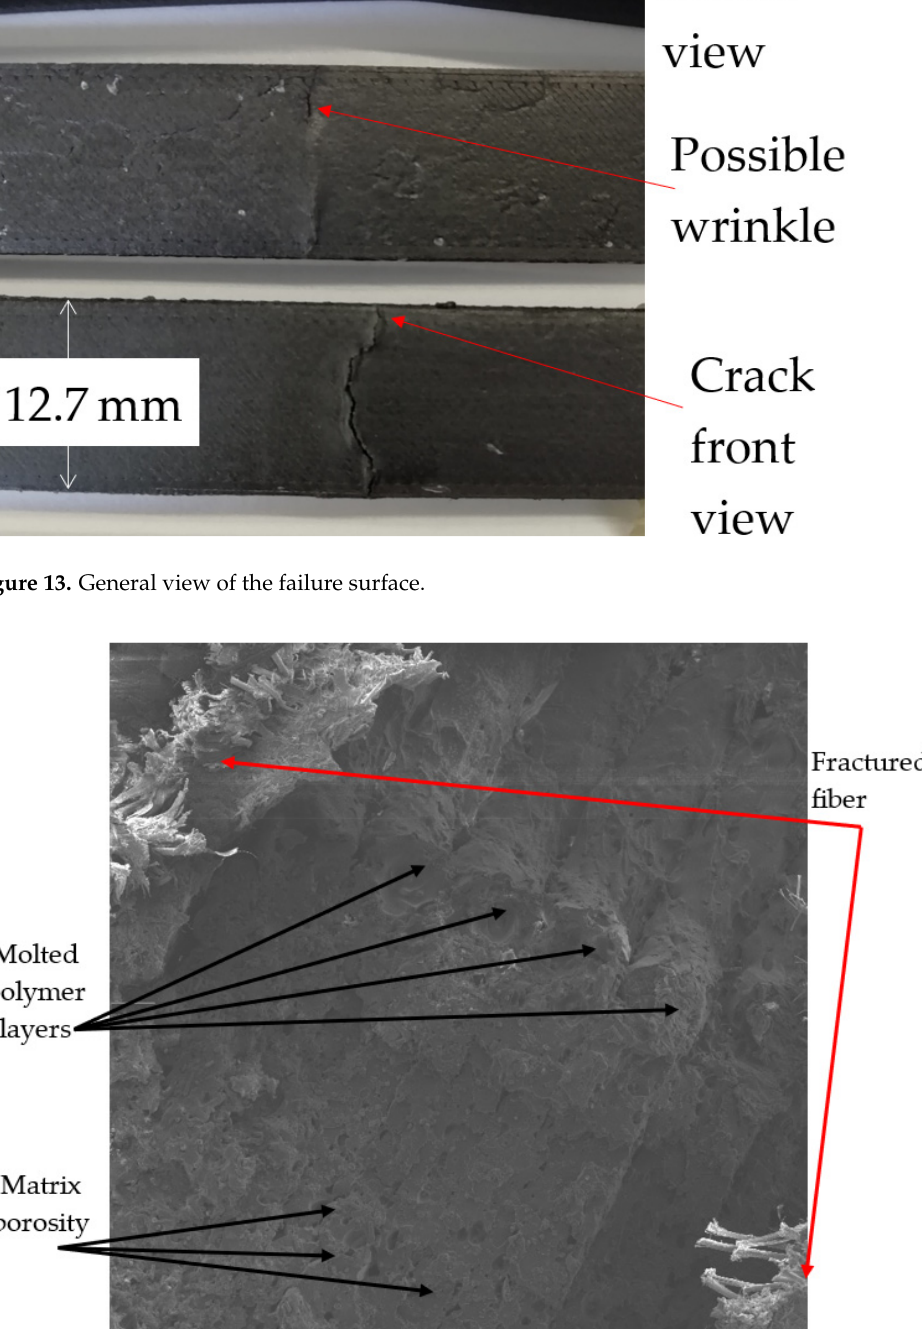
Figure 15. ( a ) close up of fiber pull out in axial static test, ( b ) fiber tearing in alternative bending . 6. Conclusions The alternative bending fatigue behavior of a polymeric matrix composite material reinforced with continuous Kevlar fiber and printed by the novel Fused Filament Fabri- cation technique was analyzed. For this, the geometry of the specimens was established